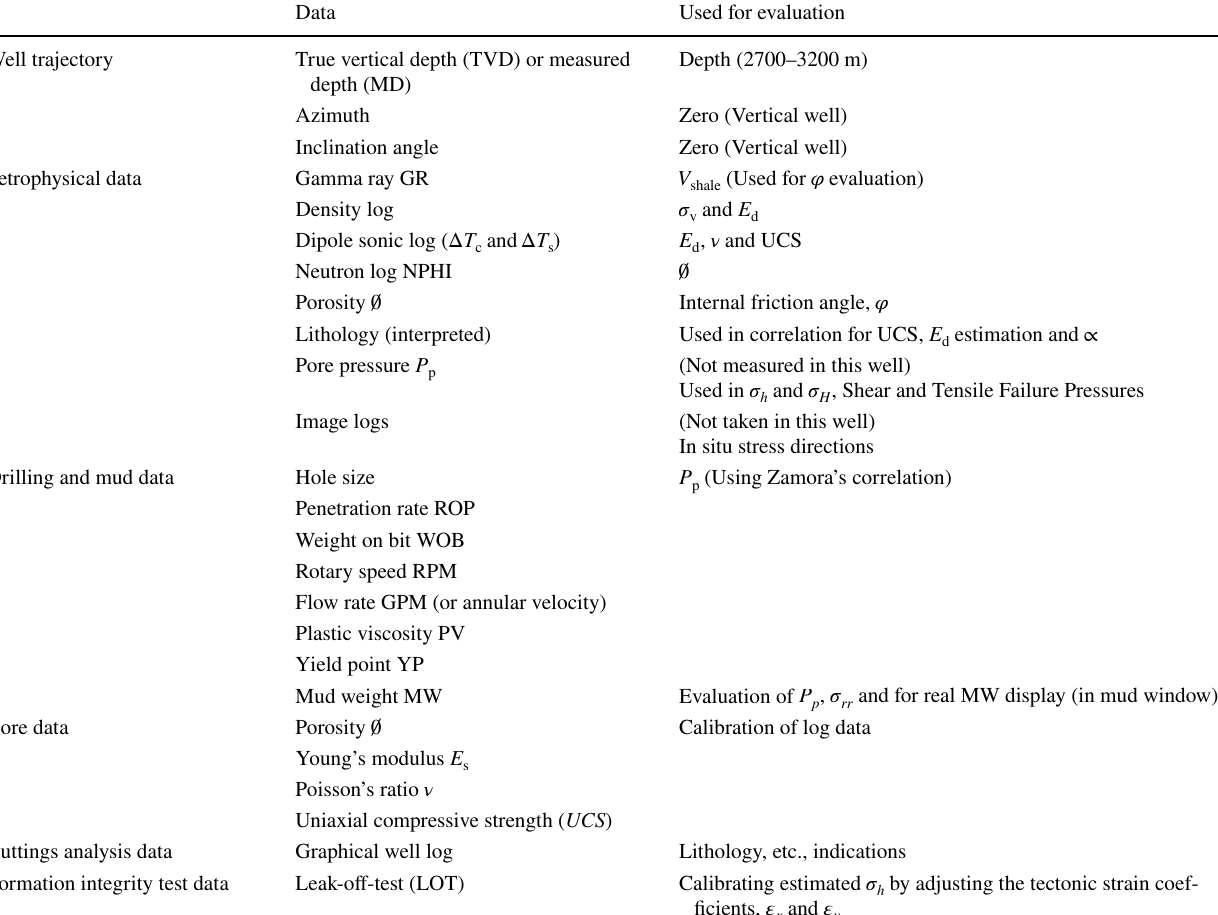
Table 2 Input data used for constructing the MEM in well Z26 and in which evaluations, they were